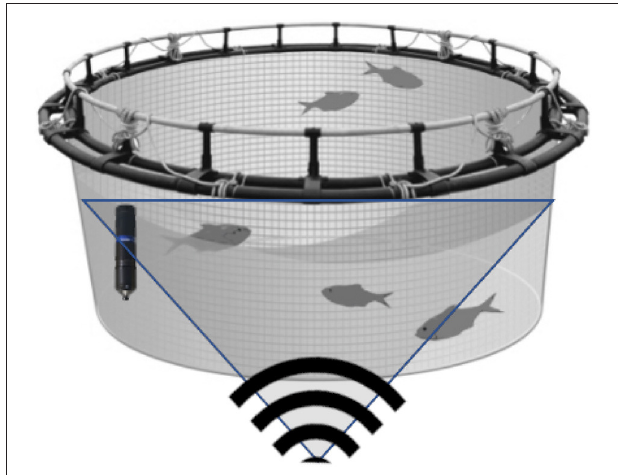
FIGURE 1 | Schematic of sensor configuration within a cage. The environmental sensor is denoted in the left hand side of cage with the exact location varying across sites (e.g., for Norway it was deployed at 5 m depth in centre of cage), while the hydroacoustic sensor and it’s sampling domain is denoted beneath the cage (pointing upwards). Note, that the hydroacoustic sensor contains sampling “blind spots,” especially toward the bottom of the cage which causes challenges in shallow sites where depth is limited. This figure represents an idealised representation of the deployment and naturally there are many practical considerations with regards sensor deployment (power source, ease of access, anchoring point,